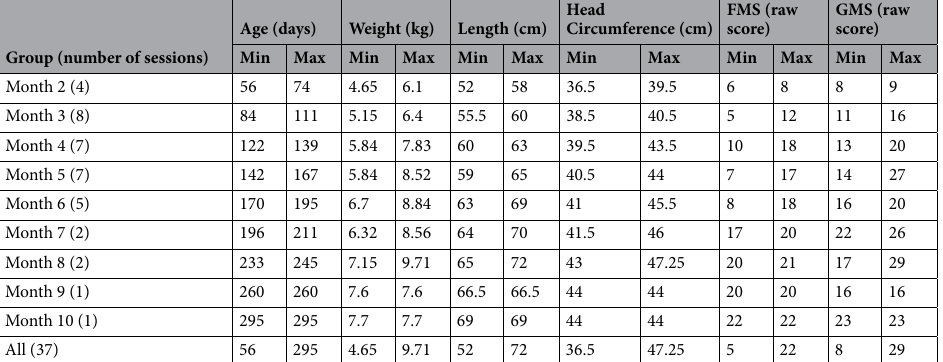
Table 4. Participant characteristics grouped by month and shown as minimum and maximum values for each measurement. Group months 9 and 10 contained 1 dataset, thus minimum and maximum are the same values. Age are in days adjusted for premature birth. Fine motor scores (FMS) and gross motor scores (GMS) are raw scores from the fine and gross motor section of the Bayley Scales of Infant Development—